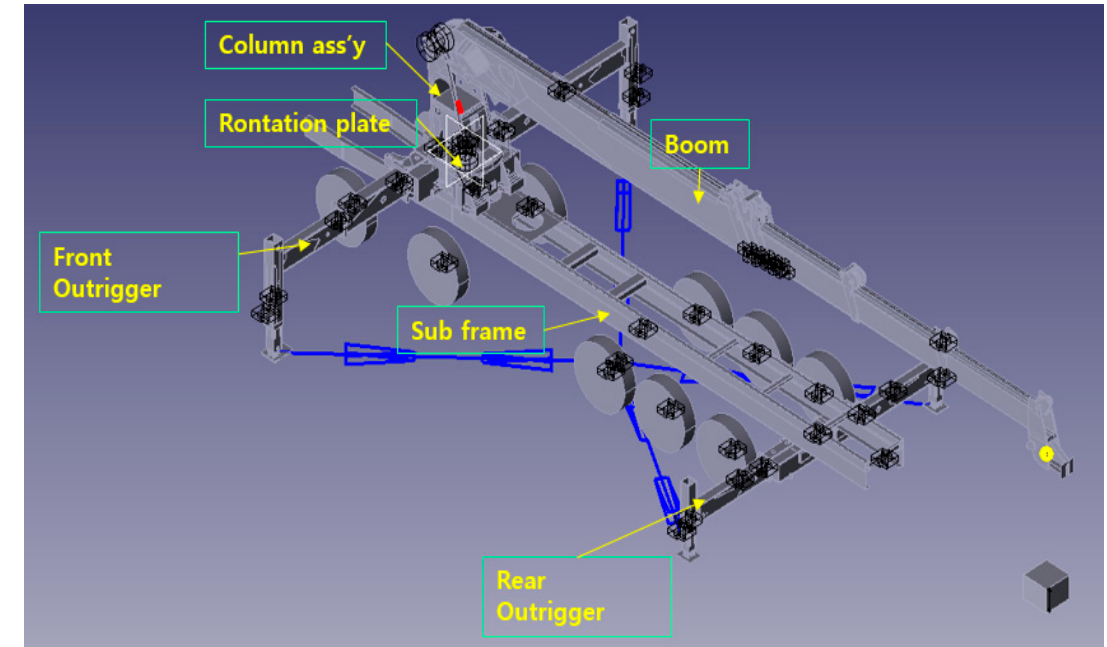
Figure 3. 3D Modeling of mobile crane (Model No. SS7506).